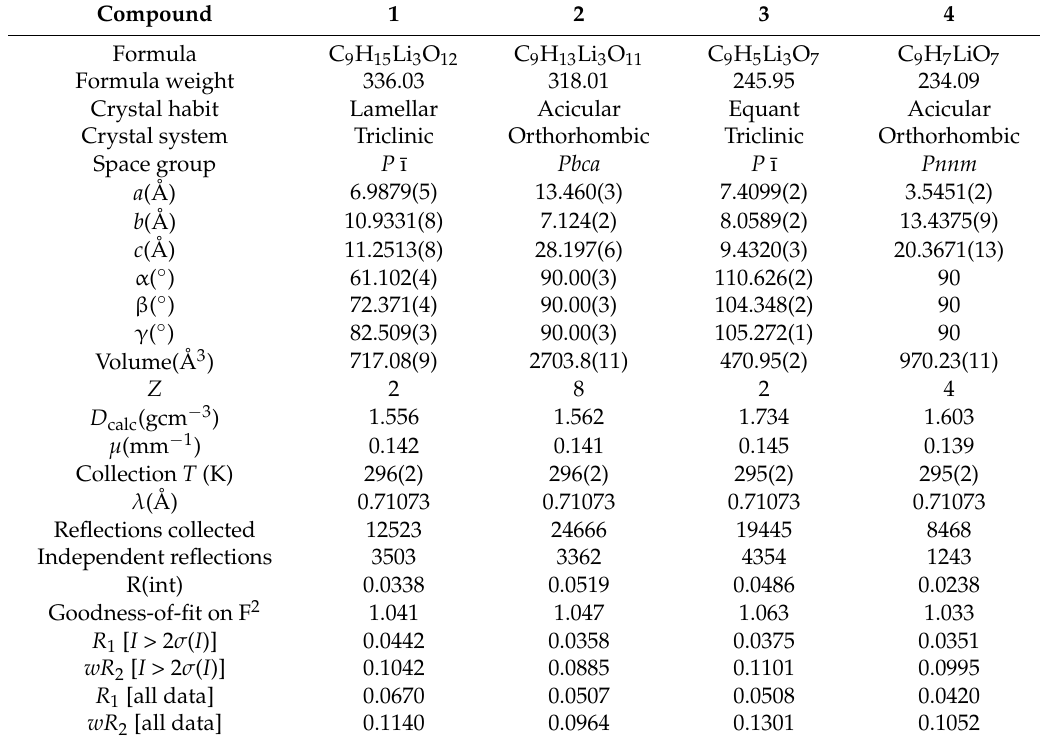
Table 1. Crystallographic data for 1 – 4